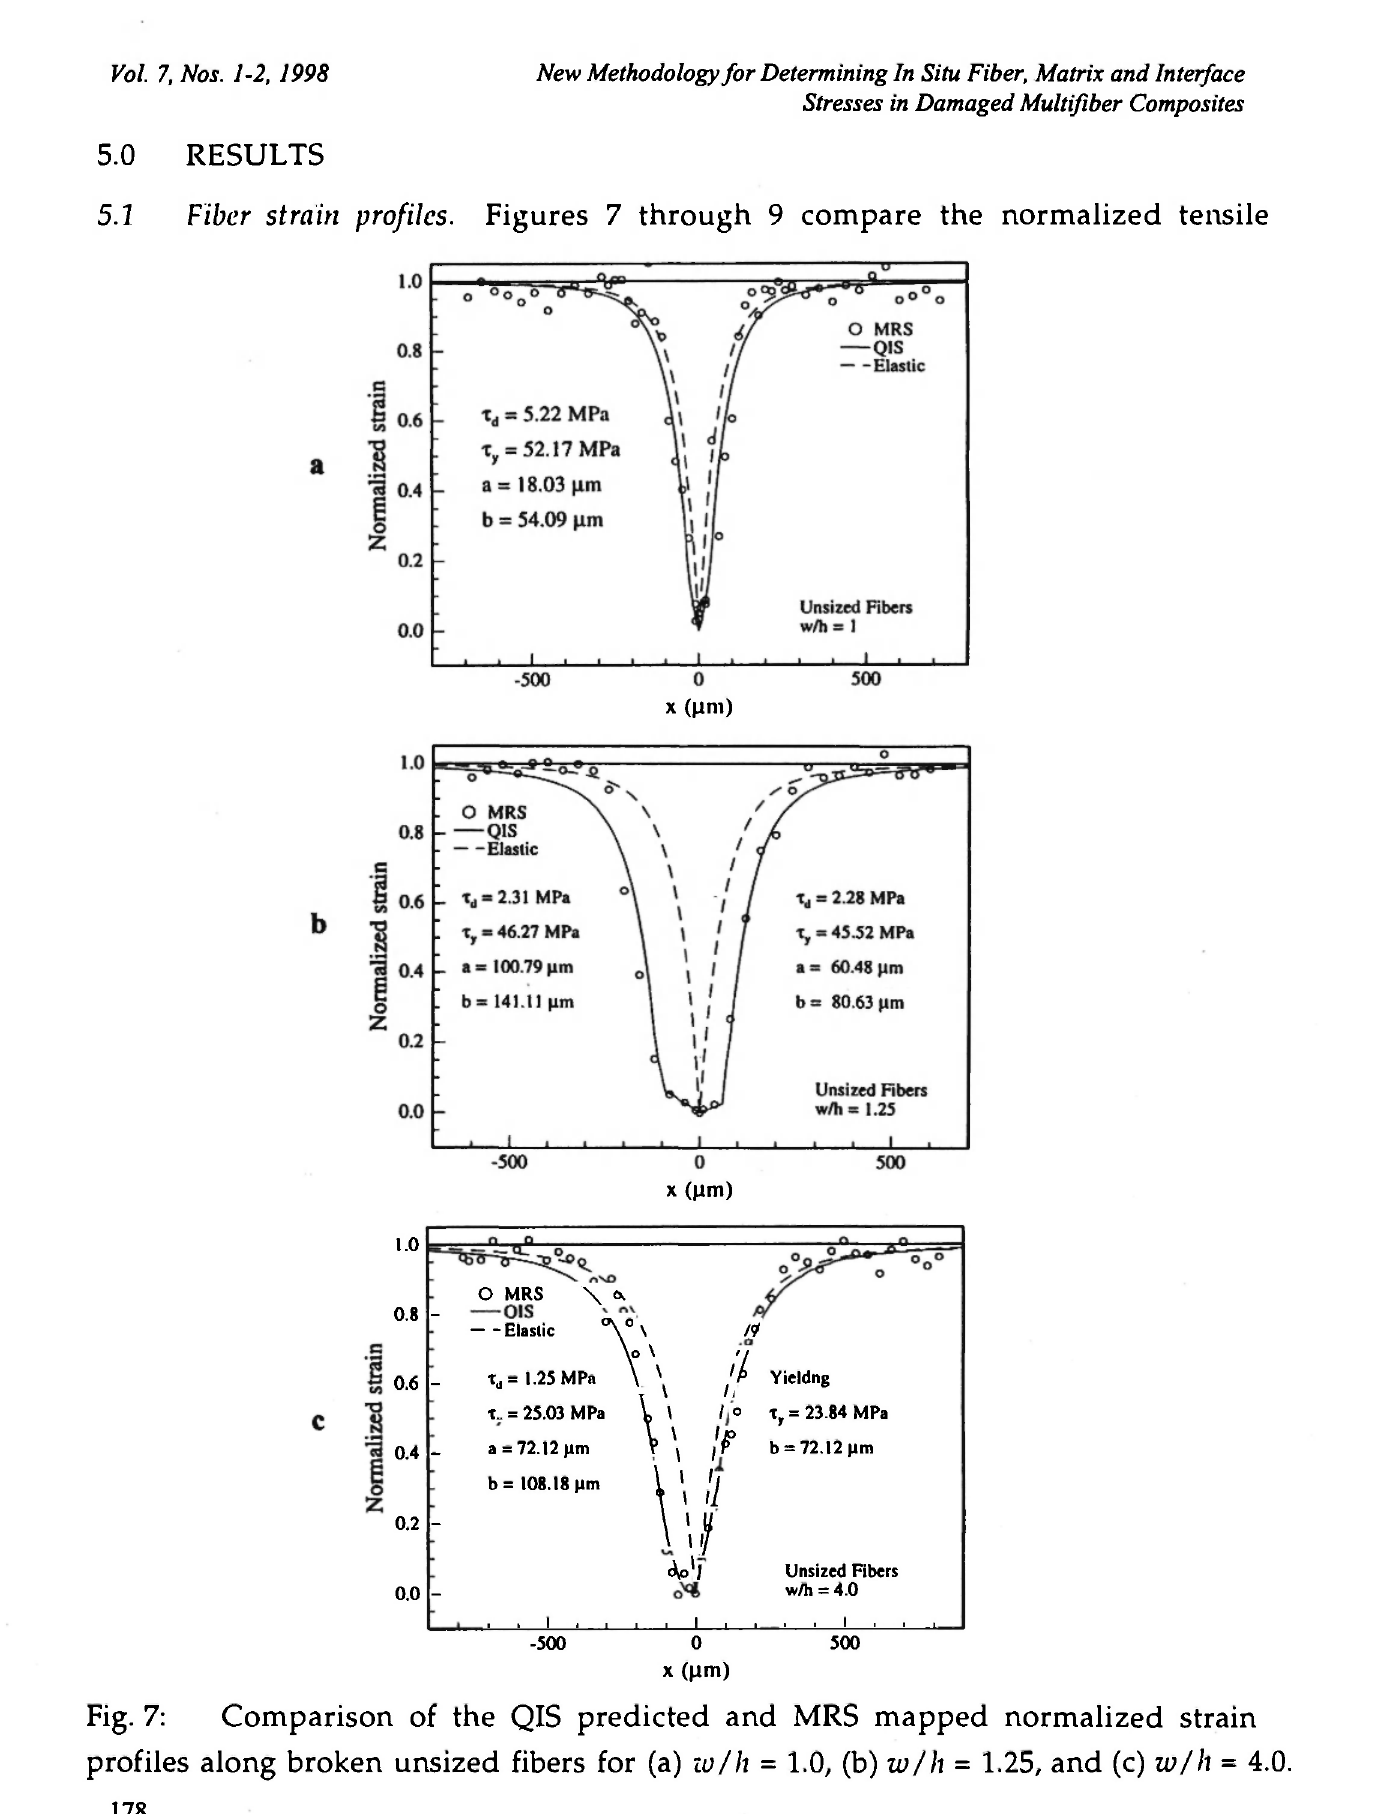
Comparison of the QIS predicted and MRS mapped normalized strain profiles along broken unsized fibers for (a) ιυ/h = 1.0, (b) w/h = 1.25, and (c) w/h =